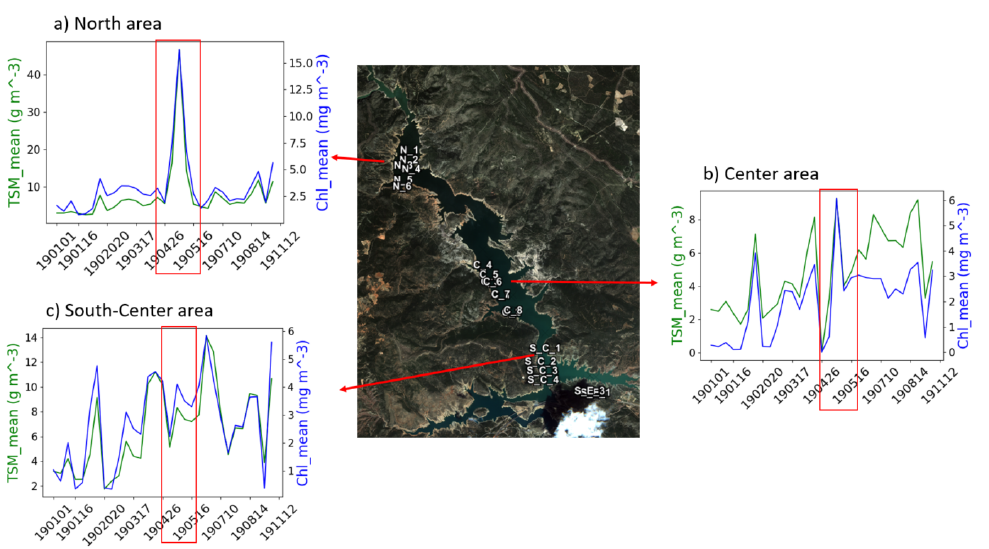
Figure 6. Time-series and areas analysis of the Contreras reservoir: ( a ) North, ( b ) Center, and ( c ) South–Center. Each figure shows the annual evolution of the average value of TSM (green line) and Chl-a (blue line). The red rectangles indicate the date analyzed, 11 May